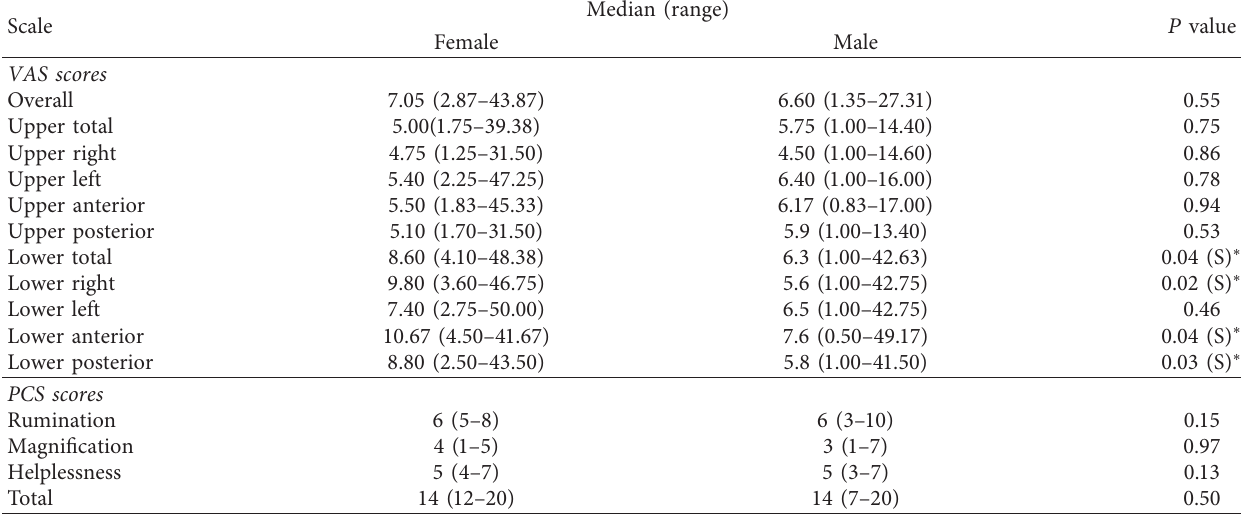
Table 5: Effect of gender on VAS and PCS